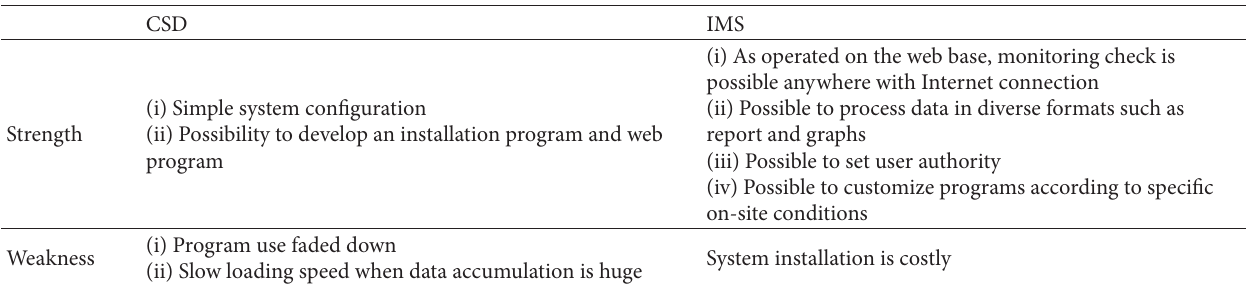
Figure 1: Flowchart of portable data logger method monitoring. Table 2: The comparison between CSD and